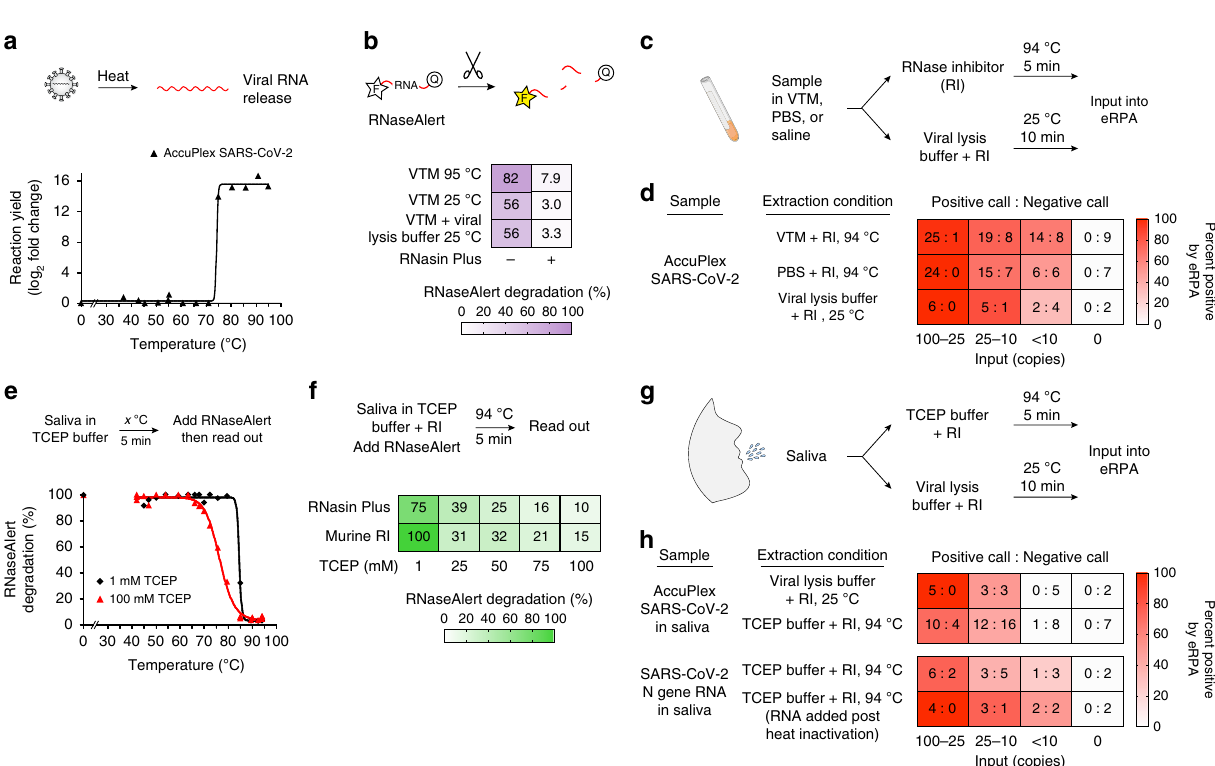
repeated three times with similar results. Source data are available in the Source Data fi